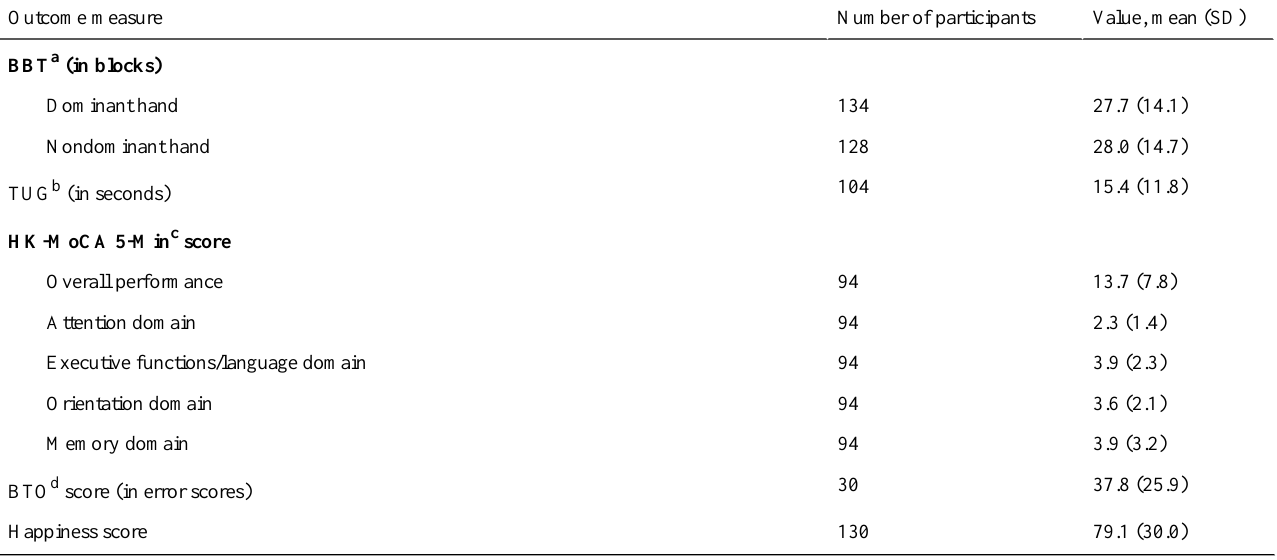
Table 7. Baseline outcome measures of the participants